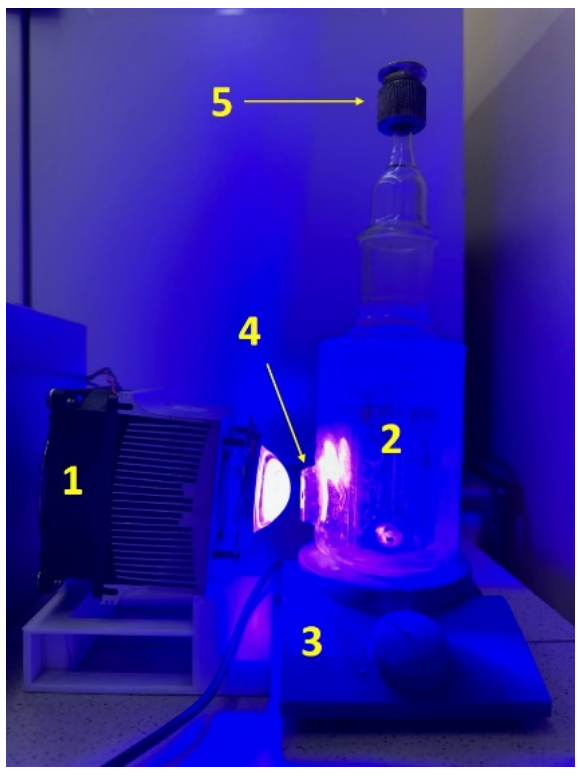
Figure 1. Photocatalytic setup for hydrogen evolution: 1—LED (425 nm); 2—suspension; 3—magnetic stirrer; 4—a quartz window; and 5—sampler.